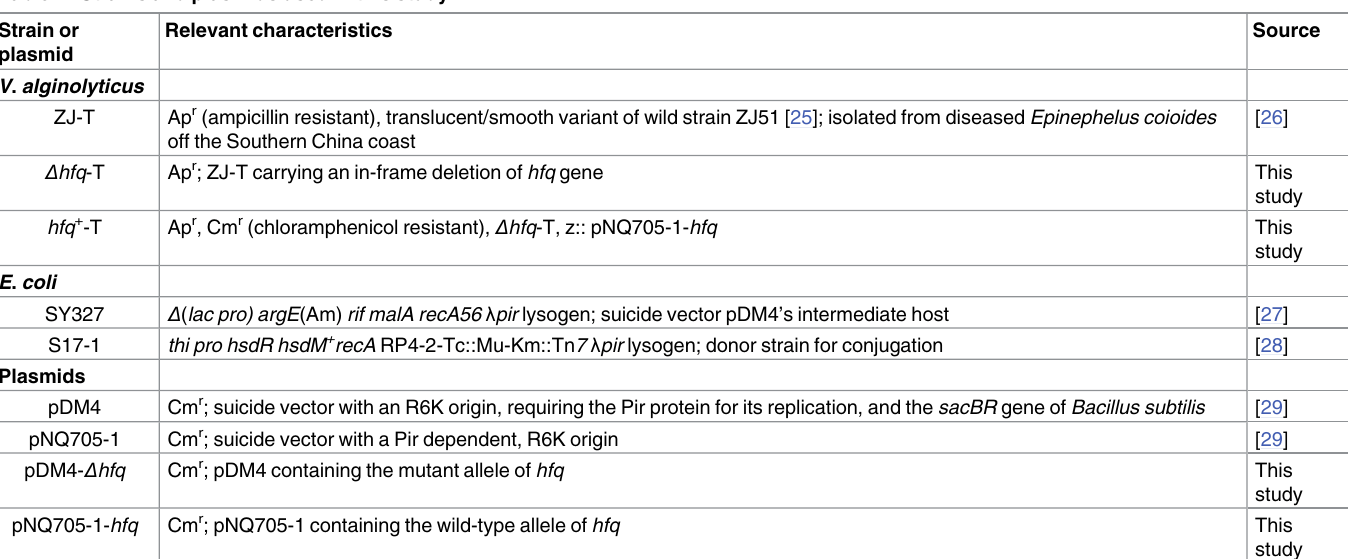
Table 1. Strains and plasmids used in this